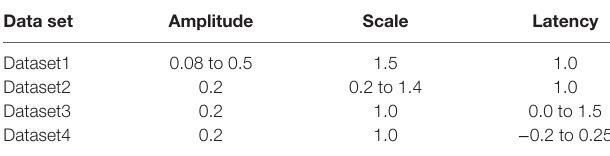
tABLe 1 | Variations in parameter values to generate test data